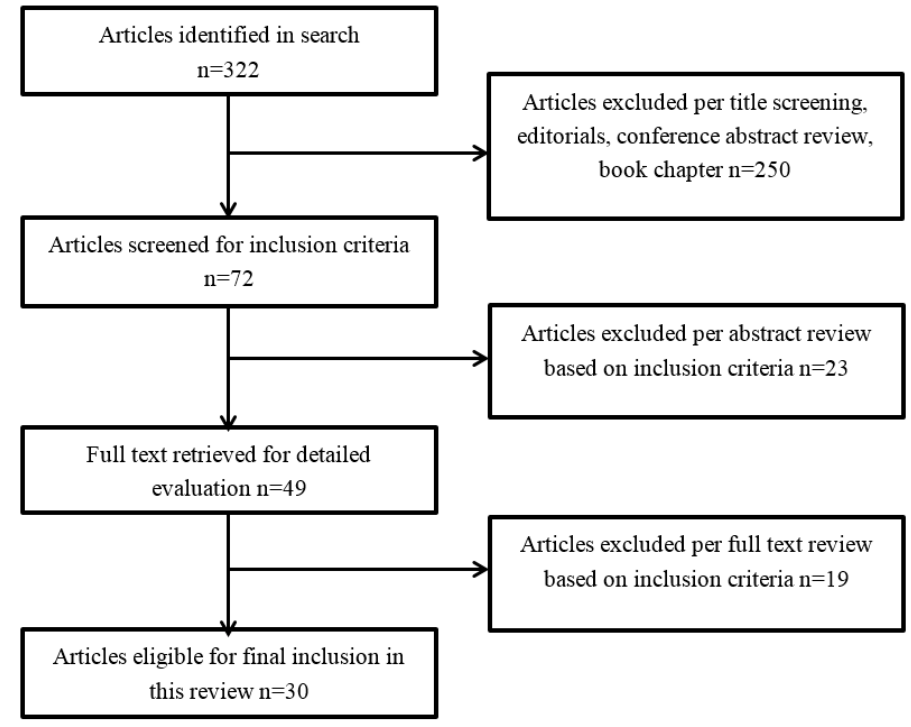
Figure 1. Details of literature review.